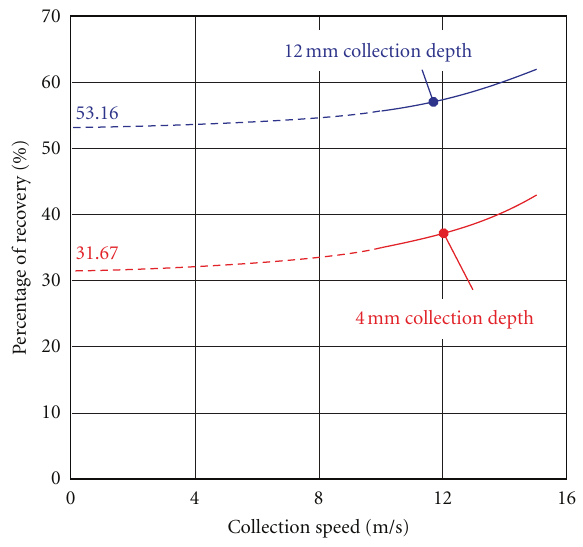
Figure 5: Percentage of recovery in relation to the depth of collection.